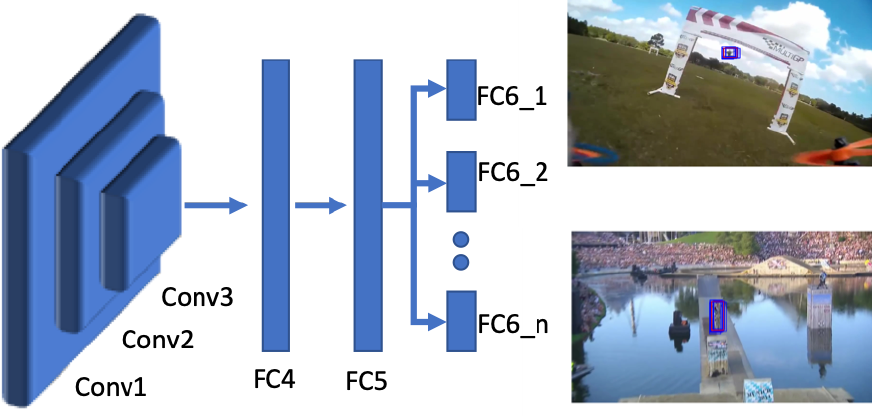
Figure 2. Network architecture of the MDNet